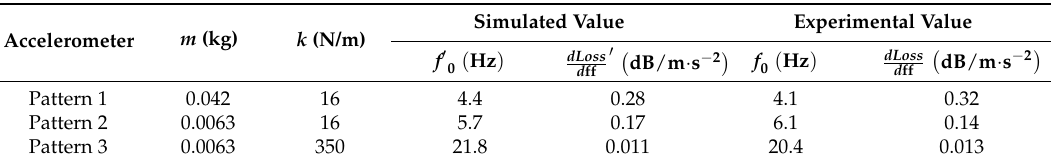
Table 1. The combinations of m and k of the proposed accelerometer, and simulated and experimental values of resonant frequency and sensitivity.